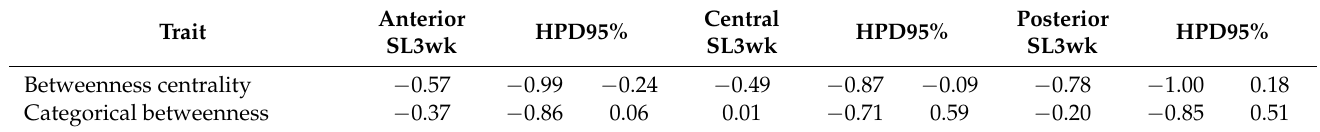
Table 6. Posterior means of the genetic correlations and the 95% highest posterior density intervals (HPD95%) of social network analysis traits recorded within 24 h post-mixing and skin lesions recorded 3 weeks post-mixing